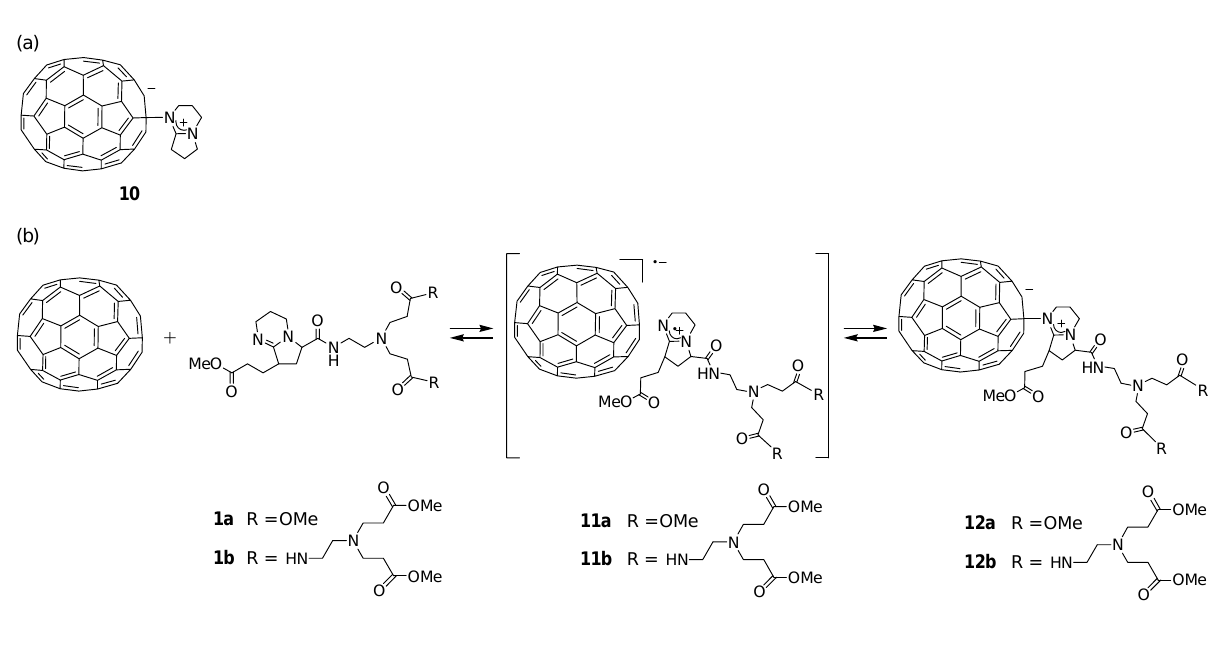
Scheme 3. (a) Structure of zwitterionic complex 10 . (b) Formation of zwitterionic fullerodendrons 12a or 12b .